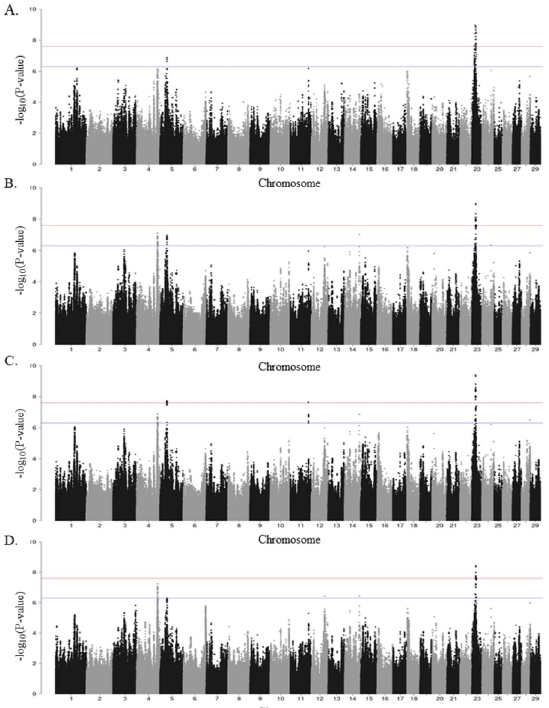
Fig 2. Manhattan plots showing–log 10 (P-values) of association between every single SNP and phenotype. Each dot represents the result from the test association for a single SNP. Animals were considered cases when they were positive to all the tests and controls when they were negative to any (+/), or all of them (+/-). Chromosomes localization of the SNPs associated with ELISA-tissue culture-tissue PCR (+/-) (A), ELISA-tissue culture-tissue PCR (+/) (B), ELISA- tissue culture (+/) (C), and ELISA-tissue PCR (+/) (D) is indicated on the x-axis. The horizontal red line is drawn at– log 10 (2.5 × 10 − 8 ), and the horizontal blue line at–log 10 (5 × 10 − 7 ) to show the high level of significance.